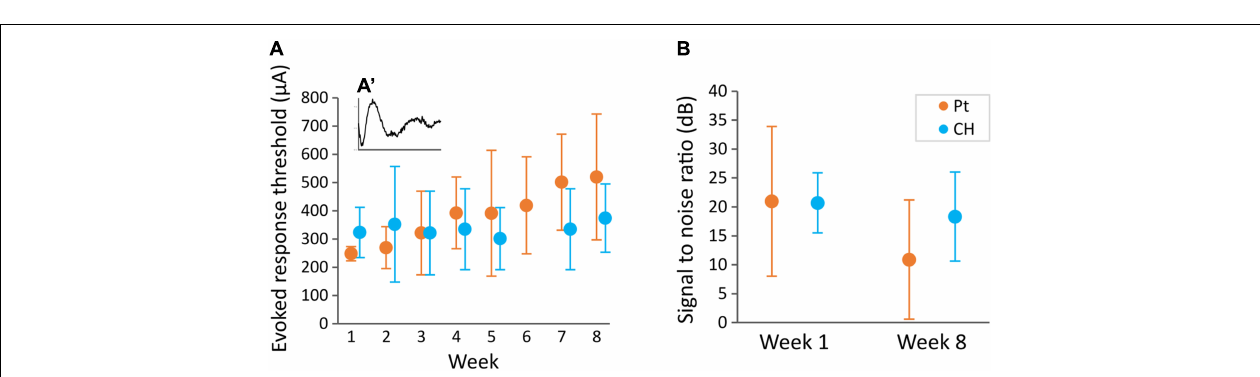
FIGURE 9 | Evoked potential threshold measured weekly and signal to noise ratio at the start and end of the study. Rats implanted with DBS electrode arrays with conductive hydrogel-coated (CH) or uncoated platinum (Pt) electrodes were stimulated with burst of 10 pulses at 80 Hz at different current levels (100–650 µ A) to record evoked responses (A (cid:48) ) . Graphs represent mean ± SD. (A) Evoked response threshold was not significantly affected by CH coating throughout the duration of the study ( p = 0.206, two-way ANOVA, 3–4 rats for Pt and CH). There was no significant effect of duration of implantation ( p = 0.470), or interaction between coating and week ( p = 0.636). (B) Signal to noise ratio was calculated from the amplitude of evoked response at 650 µ A stimulation compare to a sub-threshold stimulus. Signal to noise ratio was not significantly affected by CH coating ( p = 0.443, two-way ANOVA, 7 rats for Pt, 4 rats for CH). There was no significant difference between start and end signal to noise ratio ( p =